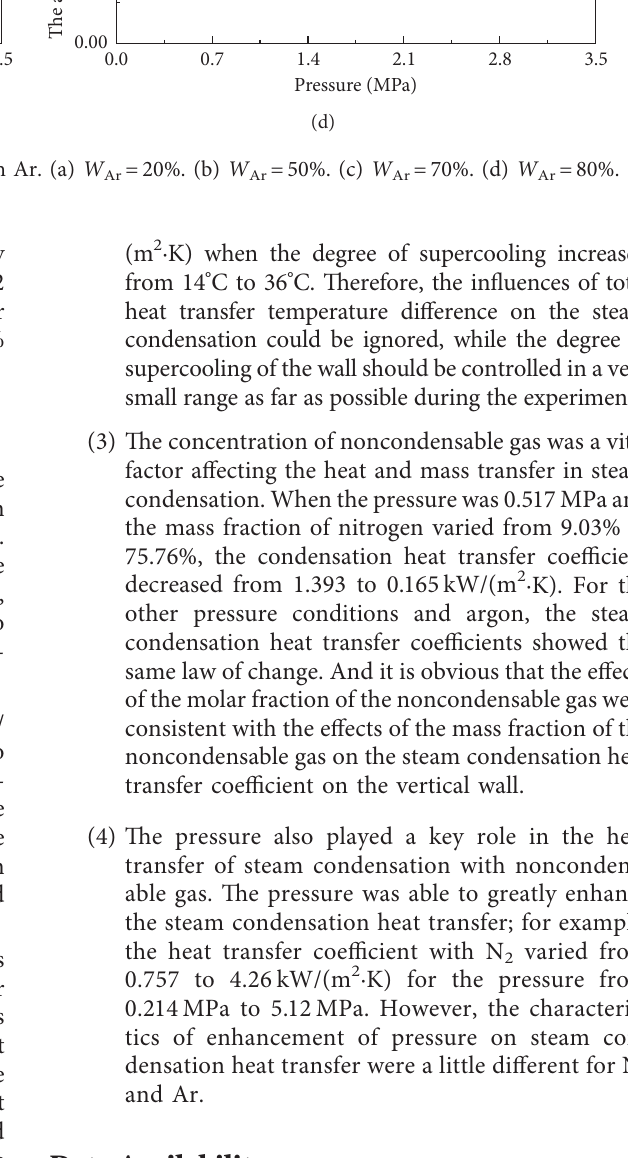
� 20%. (b) W � 50%. (c) W � 70%. (d) W � Ar Ar Ar Ar